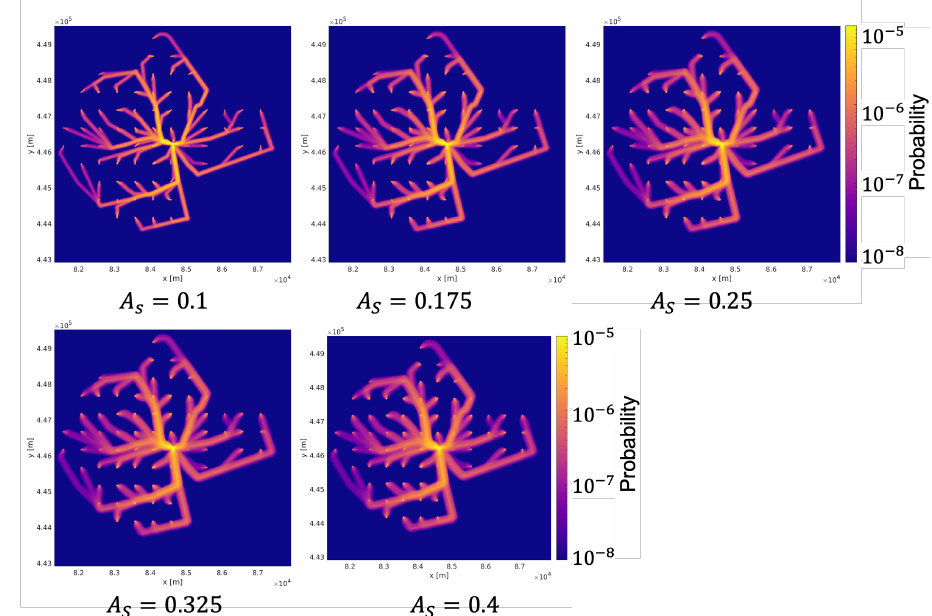
Figure A6. Annual IR with different surface area size A S